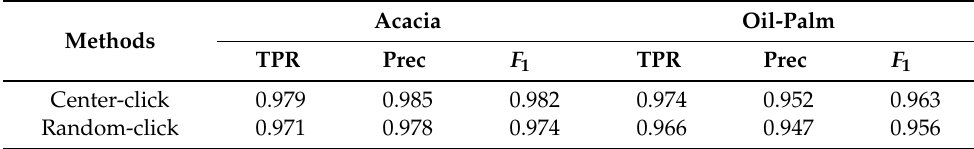
Figure 11. The examples of random annotations on acacia and oil-palm datasets. Table 5. The influence about tree counting performance with different annotations. Center-click and random-click annotations are conducted on acacia and oil-palm